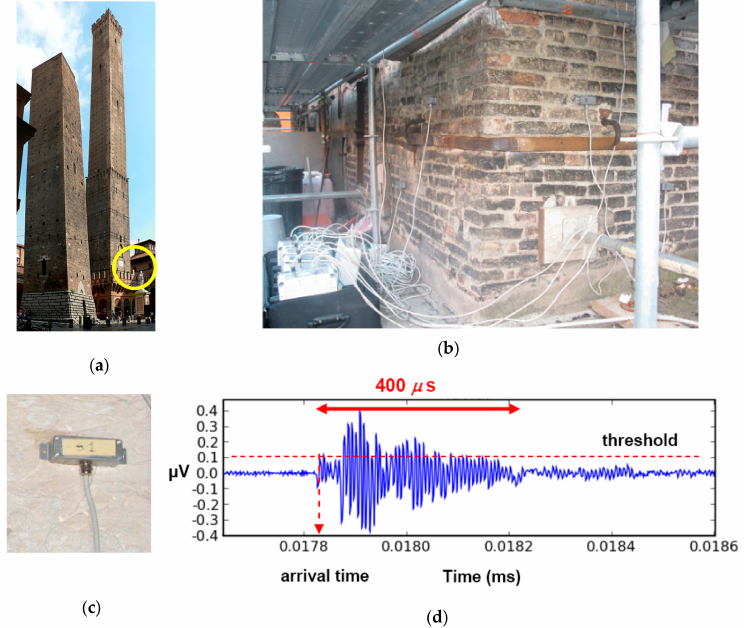
Figure 1. ( a ) The Asinelli Tower (with Garisenda Tower on the left) in the city centre of Bologna; ( b ) Monitored portion of the masonry wall with the applied AE transducers, printed from [30]; ( c ) AE transducer adopted for the monitoring; ( d ) Typical AE signal formed by the sequence of P-, S- and surface